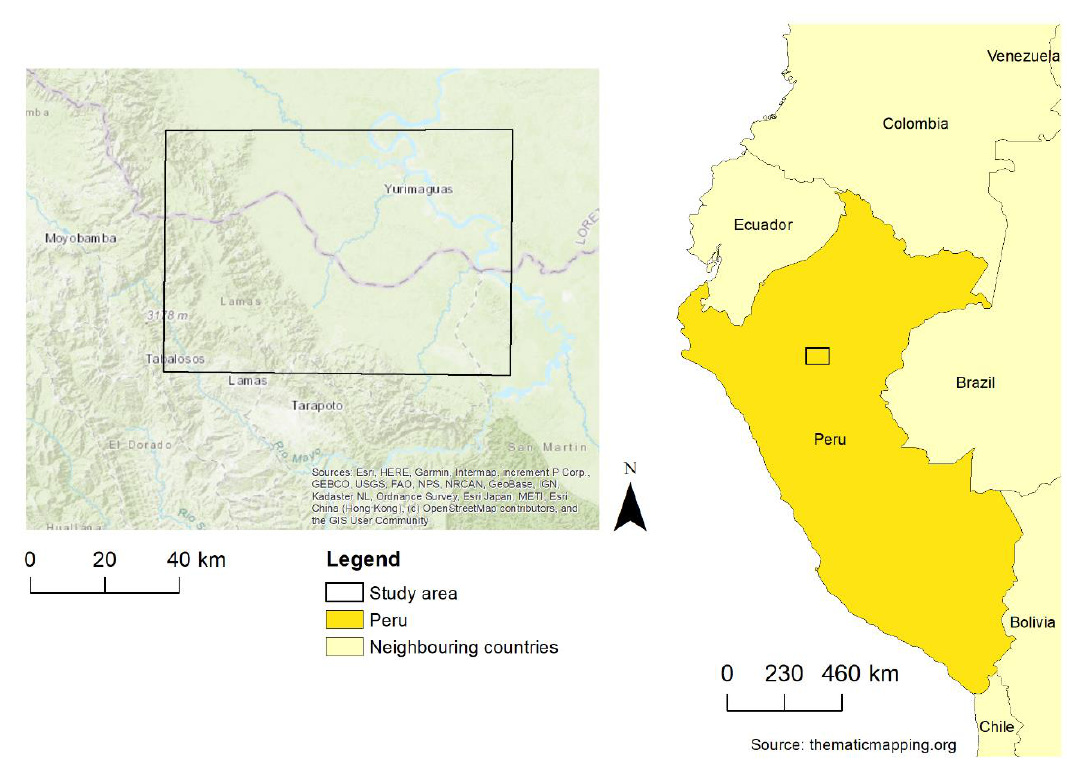
Figure 1. Test site Peru.